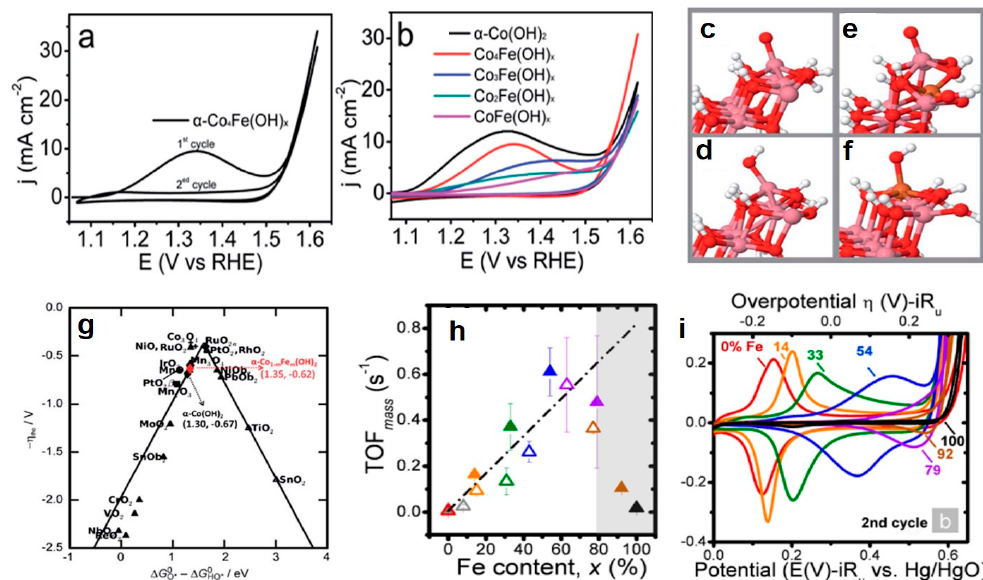
Figure 13. ( a ) Voltammetry of α -Co 4 Fe(OH) x in purified KOH showing the di ff erence between the first and second CV cycles; ( b ) the first voltammetry of di ff erent Co / Fe ratio catalysts showing a systematic anodic shift of the (nominally) Co 2 +/ 3 + wave with the increasing Fe content, O binding on ( c ) Co(OH) 2 and ( d ) α -Co 1–m Fe m (OH) 2 , OH binding on ( e ) Co(OH) 2 and ( f ) α -Co 1–m Fe m (OH) 2 (red: Oxygen; pink: Cobalt; brown: Ferrum; white: Hydrogen); ( g ) the positions of the pristine and Fe-doped α -Co(OH) 2 on the volcano curve, reproduced with permission from [12]. Copyright Royal Society of Chemistry, 2017. ( h ) Turnover frequency (TOF) data depicted based on the total film mass and composition assuming all metal sites are available for catalysis; ( i ) voltammetry of Co 1 − x Fe x (OOH) showing systematic anodic shift of the (nominally) Co 2 +/ 3 + wave with increasing Fe content, reproduced with permission from [14]. Copyright American Chemical Society, 2015.